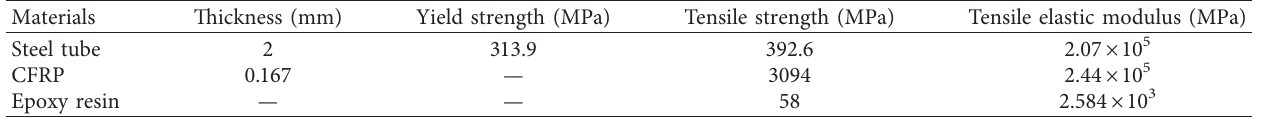
Table 1: Material properties.